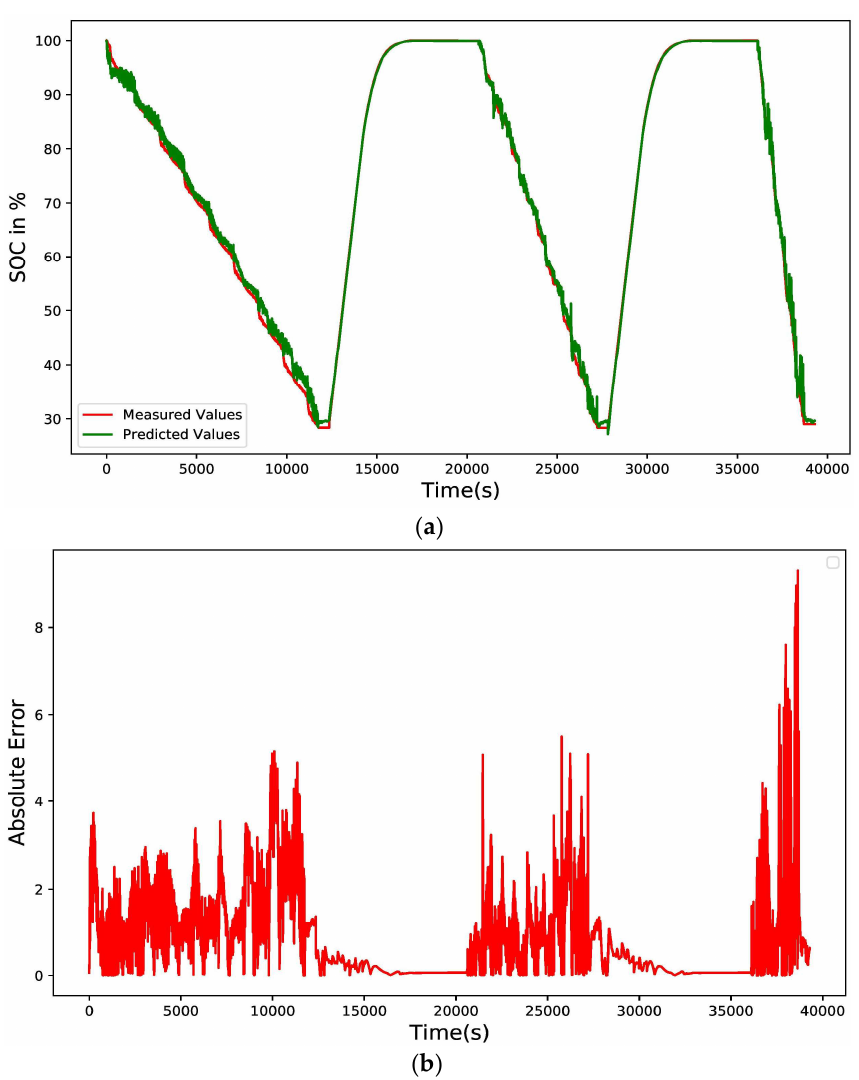
Figure 11. Performance of the CNN-LSTM model at −10 °C ( a ) measured and predicted SOC values and ( b ) absolute errors from the test data.